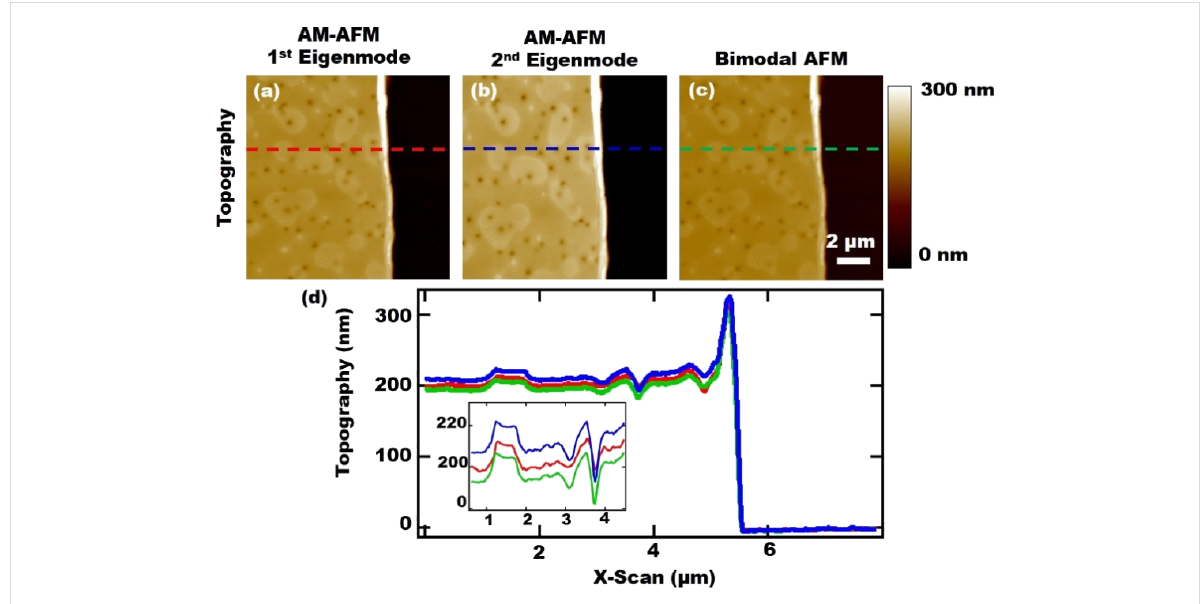
Figure 3: Polystyrene thin-film topography images for AM-AFM using the fundamental eigenmode (a), AM-AFM using the second eigenmode (b), and bimodal AFM using the first two eigenmodes (c); (d) shows the scan line profiles, whereby the color code on the graph is based on the dashed lines in the images. The inset graph is the enlarged graph of a portion of the topography in order to show the differences in topography values among the three different experiments. f 1 ≈ 45 kHz, f 2 ≈ 280 kHz, k 1 ≈ 5.80 N/m, k 2 ≈ 210 N/m, A 1 ≈ 350 nm, A 2 ≈ 11 nm, amplitude setpoint (on the controlled amplitude) = 50%. For all the experiments the oscillation amplitudes were selected such that k 1 A 1 ≈ k 2 A 2 . The setpoint was selected such that the ex- periments remained in the repulsive